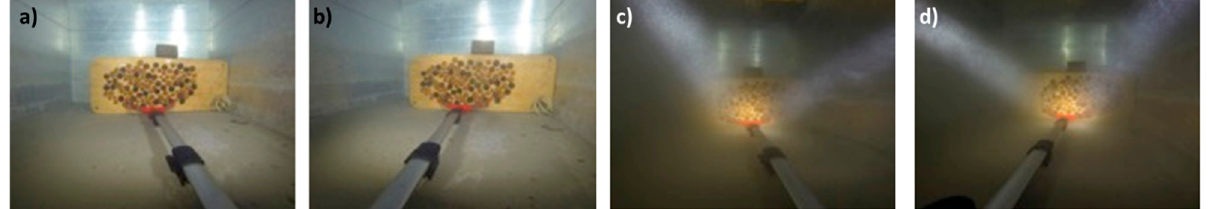
Figure 6. UN-SEA-MDTC, two tanks 300 cm × 60 cm × 50 cm.